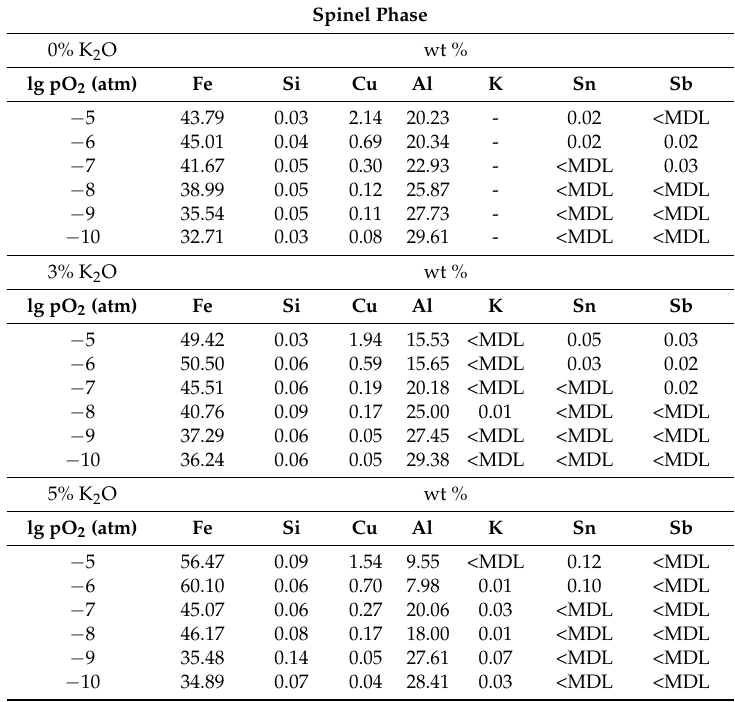
Table A4. Concentrations of iron, silicon, copper, aluminum, potassium, tin and antimony in spinel phase. All values are shown in ppmw. The analyses were taken from spinels surrounded by slag whenever possible, i.e., when they formed (above 10 − 8 or 10 − 7 atm). <MDL = below minimum detection limit of